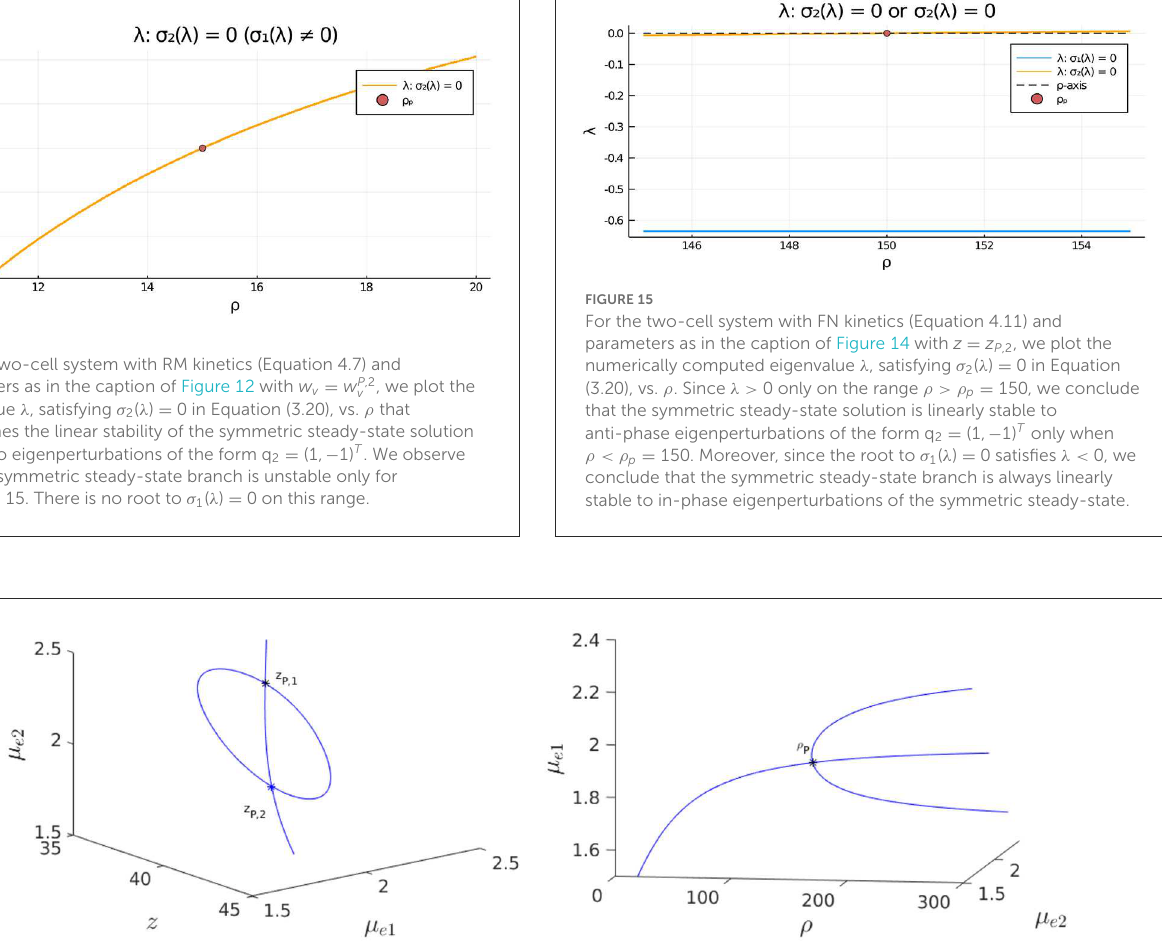
FIGURE14 3-D Bifurcation diagram, computed from Equation (4.12) using MatCont [51], for symmetric and asymmetric steady-states of a two-cell ring pattern with ring radius r 0.5 and with FN kinetics (Equation 4.11). Left: 3-D Plot of ( µ e 1 , µ e 2 ) showing that asymmetric steady-states occur inside the supercritical = d v / d u pitchfork bubble delimited by z P ,1 36.75458 and z P ,2 41.26889 when ρ 150. Right: Supercritical pitchfork bifurcation from the symmetric ≈ ≈ = = z P ,2 . Linearly stable asymmetric branches exist past this threshold in ρ . Parameters: branch occurs at ρ p 150 when z = = D u 1, D v 4, σ u 1, ε 0.03, r 0.5, q 1, δ 0.1, and d u σ v = = = = = = = = =